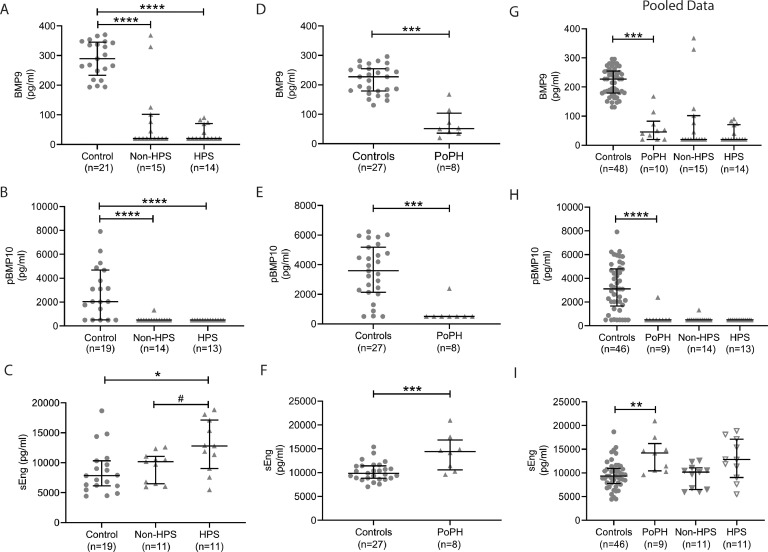
Circulating BMP9 and pBMP10 levels are reduced in PoPH and HPS, whereas sEng levels are elevated in both syndromes. Plasma samples ELISA data were for (A) BMP9, (B) pBMP10 or (C) sEng in cirrhotic patients were allocated according to the presence or absence of HPS, with controls shown for reference. Plasma samples from a separate cohort of controls and patients with confirmed PoPH were assayed by ELISA for (D) BMP9, (E) pBMP10 or (F) sEng. (G–I) The datasets for the control group samples and PoPH patients form both cohorts were combined and analysed to assess the levels of (G) BMP9, (H) pBMP10 and (I) sEng in the overall PoPH cohort. The data for the HPS patients are included in these graphs for reference. Error bars show median and interquartile range. Kruskal Wallis test: *P<0.05, **P<0.01, ***P<0.001, ****P<0.0001, Mann Whitney Test: #P<0.05.